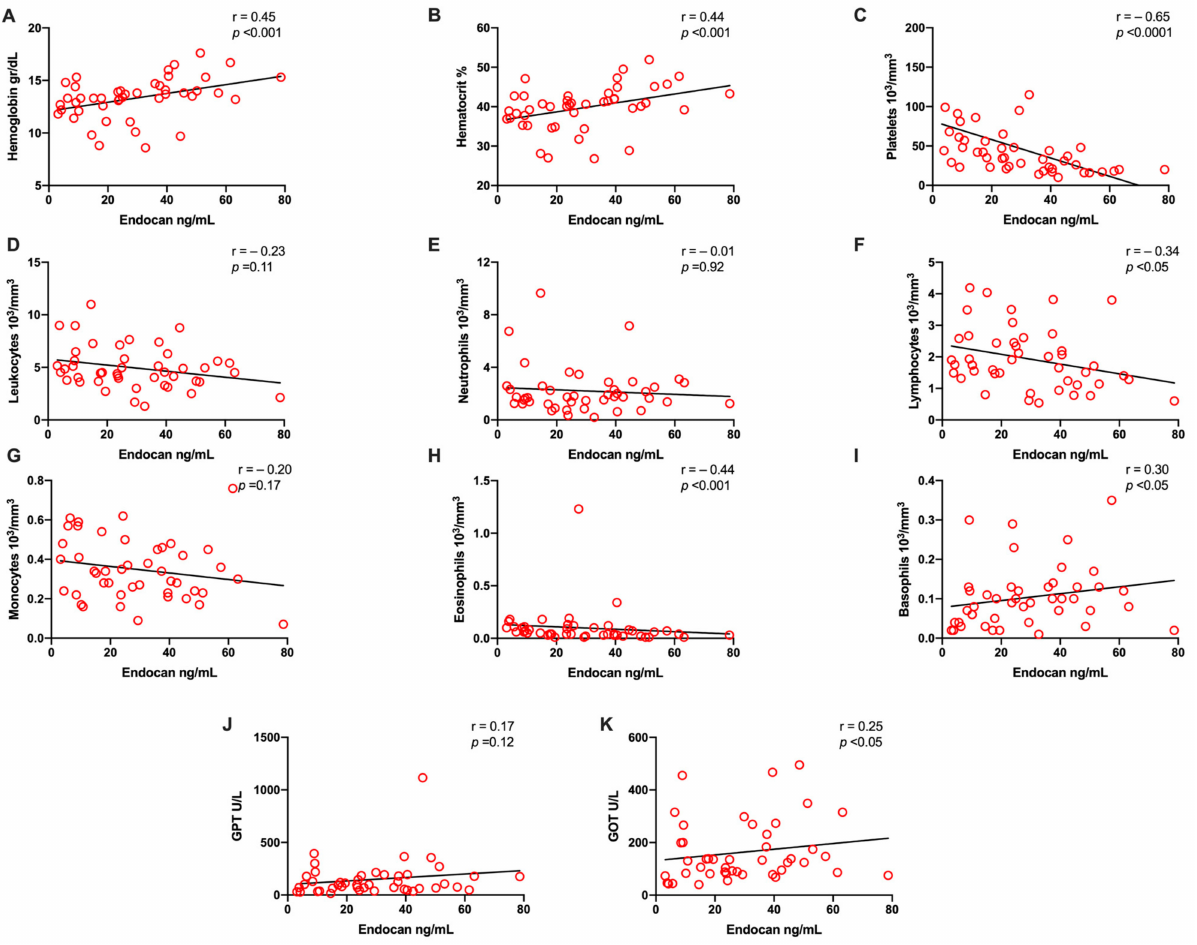
Figure 3. Correlation between Endocan serum levels and hematological and biochemical laboratory parameters in dengue infection. Correlations between endocan serum levels and hemoglobin ( A ), hematocrit ( B ), platelet ( C ), leukocyte ( D ), neutrophil ( E ), lymphocyte ( F ), monocyte ( G ), eosinophil ( H ), basophil ( I ), GPT ( J ), and GOT levels ( K ) were